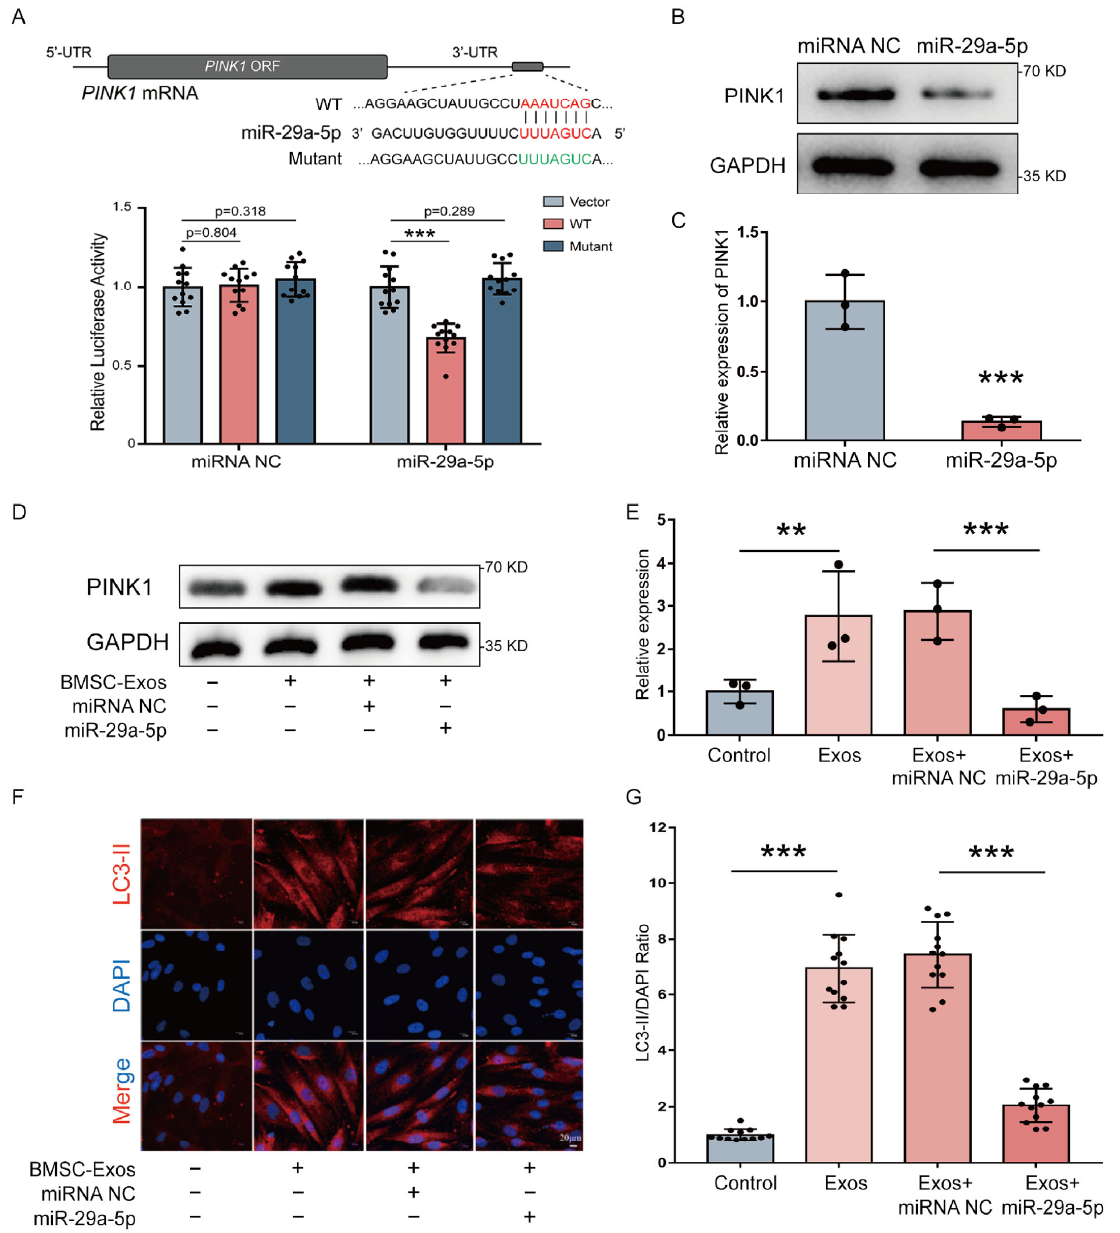
Figure 5. CircHIPK3 promoted mitophagy of MC3T3 ‐ E1 cells through miR ‐ 29a ‐ 5p/PINK1 axis. ( A ) Schematic representation of PINK1 3 ′‐ UTR with the predicted target site for miR ‐ 29a ‐ 5p. The mutant site of PINK1 3 ′‐ UTR is indicated (green). Luciferase reporter analysis was performed to examine the binging ability between miR ‐ 29a ‐ 5p and PINK1 3 ′‐ UTR. Reporter constructs containing either PINK1 3 ′‐ UTR ‐ wt or PINK1 3 ′‐ UTR ‐ mut at the predicted miR ‐ 29a ‐ 5p target sequences were co ‐ transfected into HEK293T cells, along with miR ‐ 29a ‐ 5p or miRNA NC mimics ( n = 12). ( B , C ) Western blot assay and quantification of PINK1 in MC3T3 ‐ E1 cells transfected with miR ‐ 29a ‐ 5p or miRNA NC mimics ( n = 3). *** p < 0.001. ( D , E ) Western blot assay and quantification of PINK1 in MC3T3 ‐ E1 cells treated with PBS (control), BMSC ‐ Exos (Exos), BMSC ‐ Exos and miRNA NC (Exos + miRNA NC) or BMSC ‐ Exos and miR ‐ 29a ‐ 5p mimic (Exos + miR ‐ 29a ‐ 5p) ( n = 3). ** p < 0.01, *** p < 0.001. ( F , G ) Representative LC3 immunofluorescence staining (LC3 stained with red and nuclei stained with blue) and quantitative results of LC3 intensity ( n = 12). *** p < 0.001. Bar: 20 μ m.